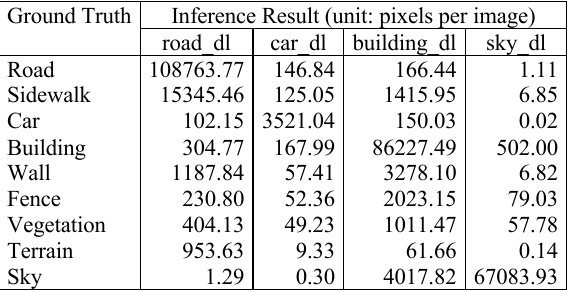
Table 2 . NFIP for the selected pairs of landscape